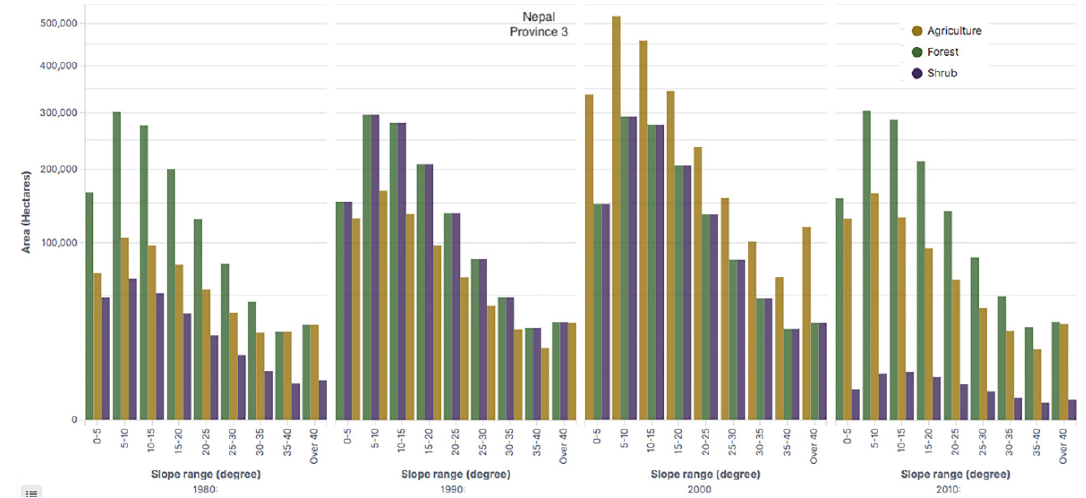
Figure 14. Province 3: forest, shrubland, and agricultural areas of Nepal by 9 elevation classes for 1980, 1990, 2000, and 2010. Table 9. Province 3: land use as a percentage of total area of forest, shrubland, and agriculture for 1980, 1990. 2000, and 2010 for entire Nepal. ((Individual land-use area for a slope class/sum of forest + shrubland + agriculture) * 100).